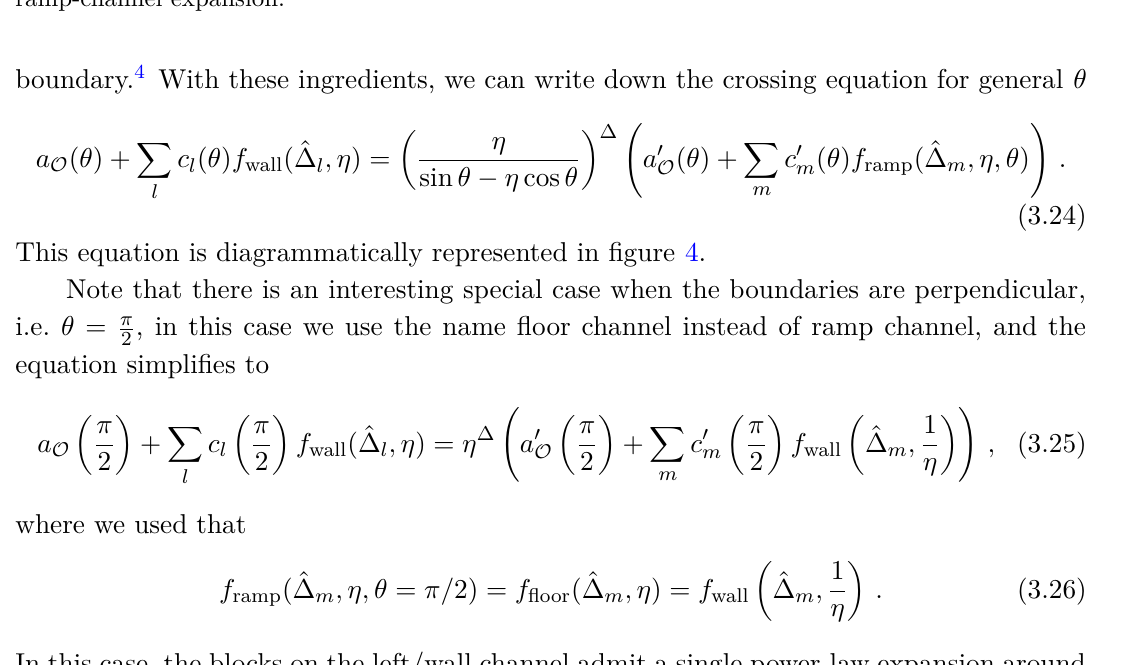
Figure 4 . Diagrammatic representation of the crossing equation for the 1-pt function near an edge. The left hand side crresponds to the wall-channel expansion and the right hand side to the ramp-channel